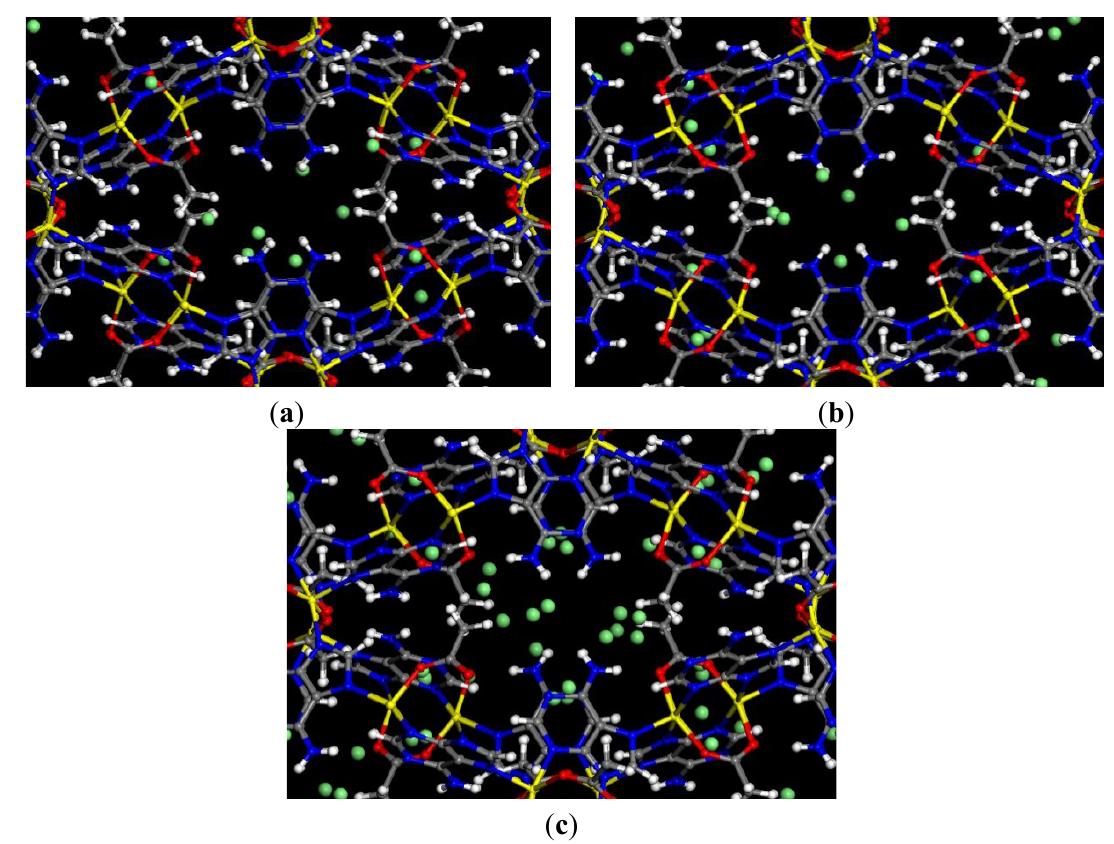
Figure 6. Simulation snapshots of CO 2 from equimolar binary mixtures of CO 2 /N 2 in bio-MOF-11 at ( a ) 0.05 MPa; ( b ) 0.1 MPa; and ( c ) 1 MPa and 298 K. CO 2 molecules are represented by green balls. The frameworks of bio-MOF-11 are represented by ball-and-stick model. (Co, yellow; C, grey; H, white; O, red; and N,